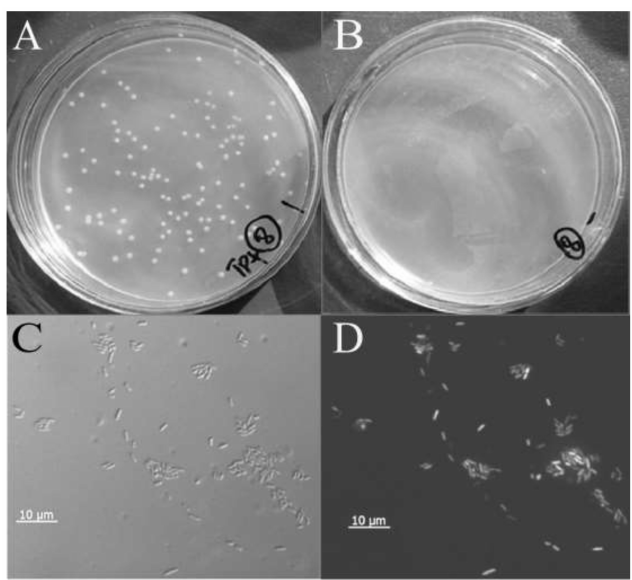
Figure 3. Colonies and microscopic observation of Smal-007 transformed by pBBR1-TpGFP. ( A ) The transformants growth on LB plate. ( B ) Negative control. ( C–D ) Fluorescence microscopy observation of the transformants. C: light field; D: UV (475cnm) field. Smal-007, Stenotrophomonas maltophilia Smal-007.